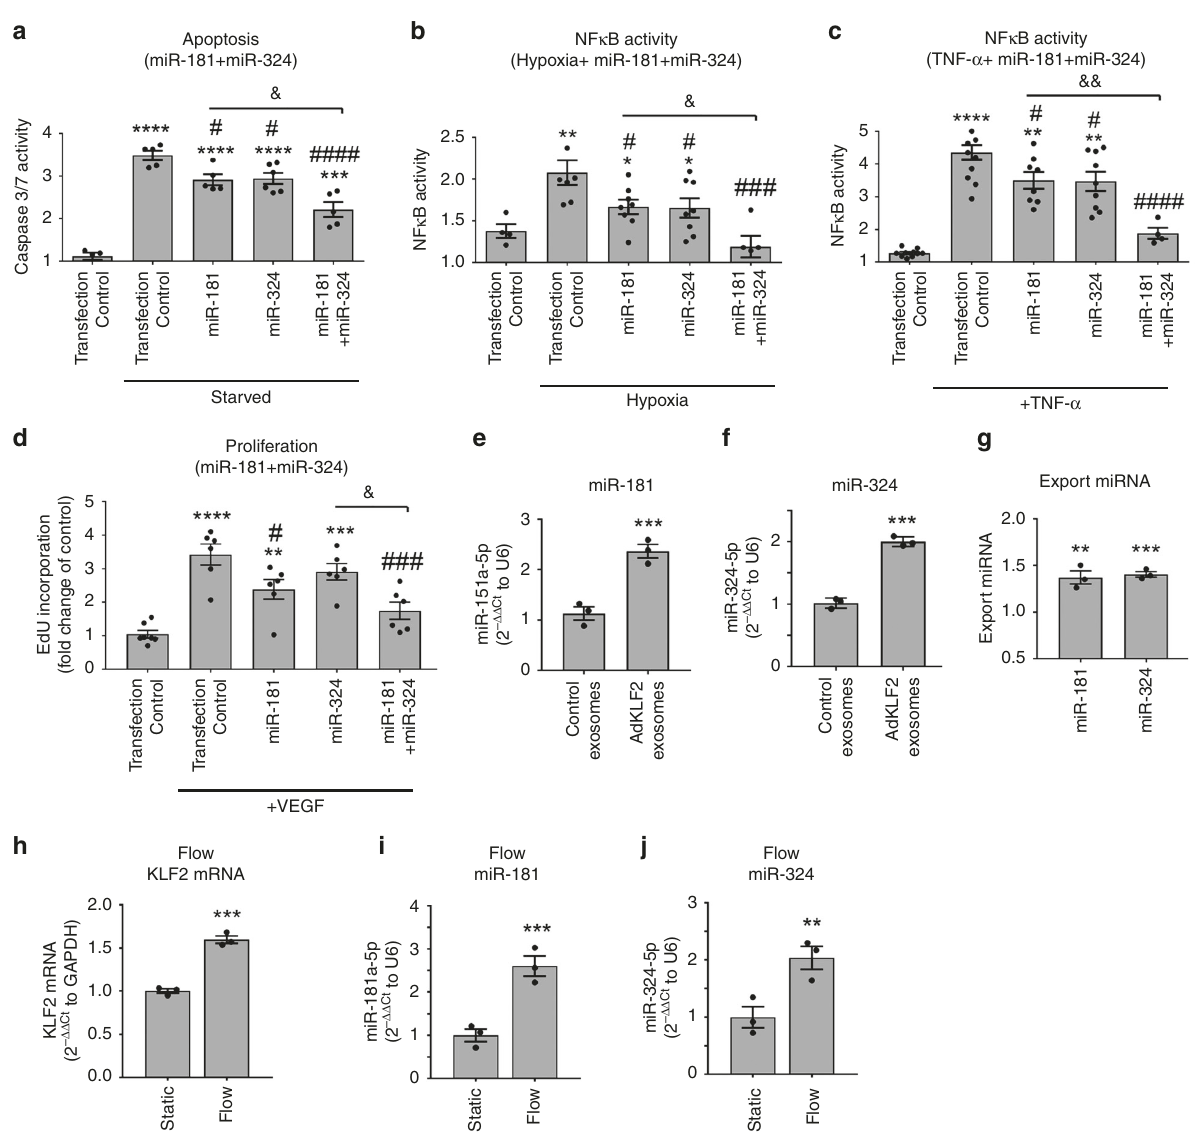
Fig. 3 miR-181 and miR-324 mediate endothelium-protective effects of KLF2 exosomes. a Anti-apoptotic, b , c anti-in fl ammatory and d anti-proliferative effects of single and combined treatments with miR-181 and miR-324. HPAECs transfected with speci fi c miRNAs were serum-starved or were infected with AdNF κ B-luc and stimulated with hypoxia or TNF- α (10 µ g/L) for 24 h. Alternatively, HPAECc grown in serum-reduced medium were treated with VEGF (50 ng/mL, 18 h). e miR-181 and f miR-324 levels in HPAECs incubated with control or KLF2 exosomes for 24 h; qPCR. g Export ratios for miR-181and miR-324. h KLF2 mRNA, i miR-181 and j miR-324 changes in HPAECs under fl ow (10 dynes/cm 2 , 24 h). Bars show mean fold change of untreated controls ± s.e.m. * P < 0.05, ** P < 0.01, *** P < 0.001, **** P < 0.0001, comparison with transfection controls; # P < 0.05, # P < 0.05, ### P < 0.001, #### P < 0.0001, comparison with treatment controls or as indicated; & P < 0.05, && P < 0.01, comparisons as indicated. One-way ANOVA with Tukey post-test ( a – d ) and unpaired t -test ( e – j ). In a n = 4 – 6, b n = 4 – 8, c n = 4 – 12, d n = 6 – 7, e – j n = 3 of independent experiments. Source data are provided in Source Data fi